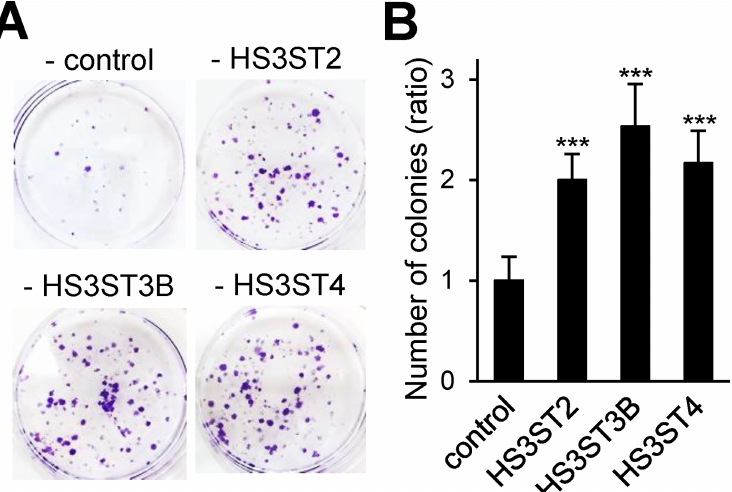
Fig 3. Effects of the expression of HS3ST2, HS3ST3B and HS3ST4 on colony formation in MDA-MB-231 cells. ( A ) Equal numbers of control and HS3ST-overexpressing cells (2000 per well) were seeded in six well plates and maintained for nine days in DMEM complemented with 1% FCS to form colonies. Fresh complete growth medium was then added for three days, after which the colonies were stained with crystal violet. The right panel ( B ) represents the quantification of the colonies per well. Results are expressed as fold changes by comparison with control cells transfected with empty vector. Data are means ± S.D. from five separate experiments performed independently ( (cid:3)(cid:3)(cid:3) P < 0.001, significantly different when compared to control